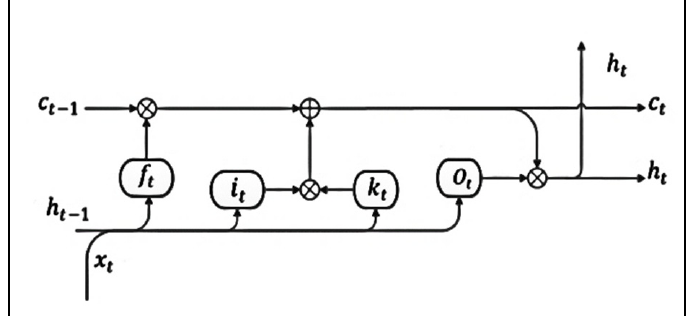
Figure 4. Long-short-term memory (LSTM) at time t.